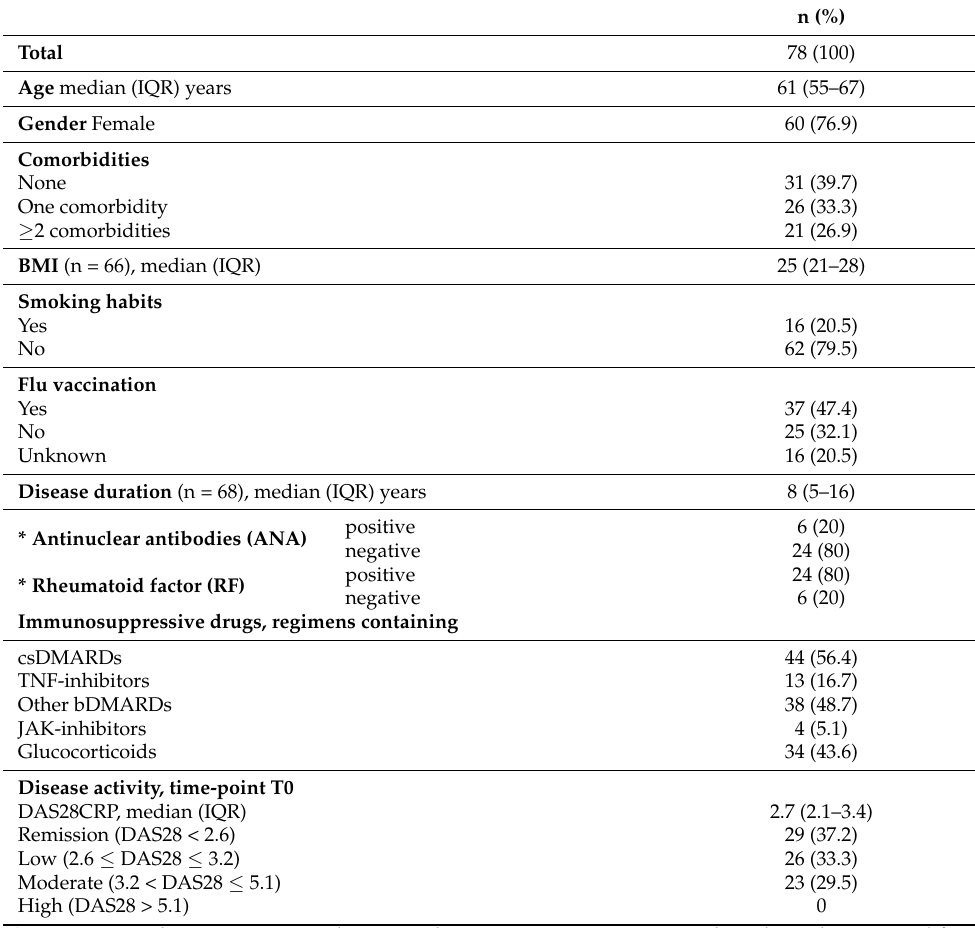
Table 1. Demographic and clinical characteristics of 78 patients with rheumatoid arthritis enrolled in the